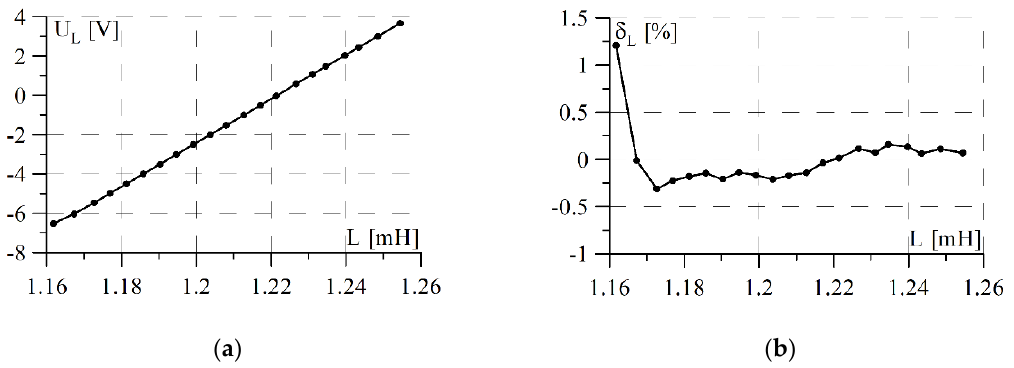
Figure 4. Characteristics of inductive sensor inductance measurement channel: ( a ) static; ( b ) relative nonlinearity error.